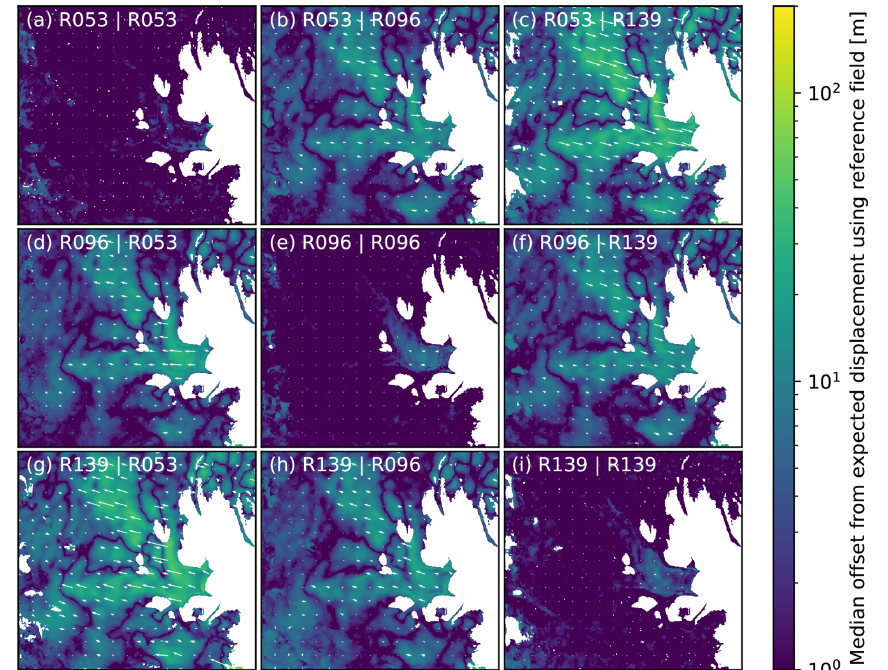
Figure 3. Median offset between measured displacement and expected displacement (from reference velocity field) for different orbital pairs at Helheim Glacier. Magnitude is shown in colour; vectors are shown as white arrows. The orbital geometry of the constituent relative orbits is visualised in Fig. S2.